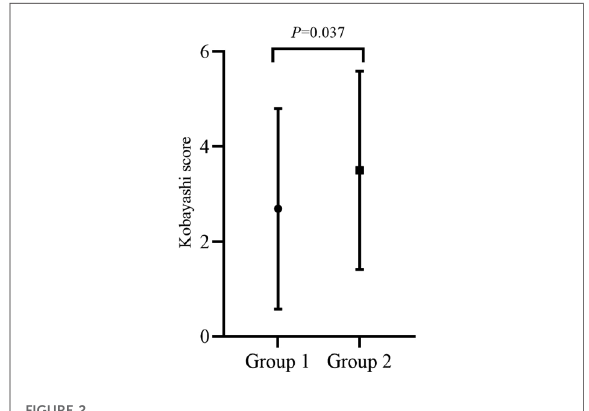
FIGURE 2 Comparison of Kobayashi scores between the two groups.